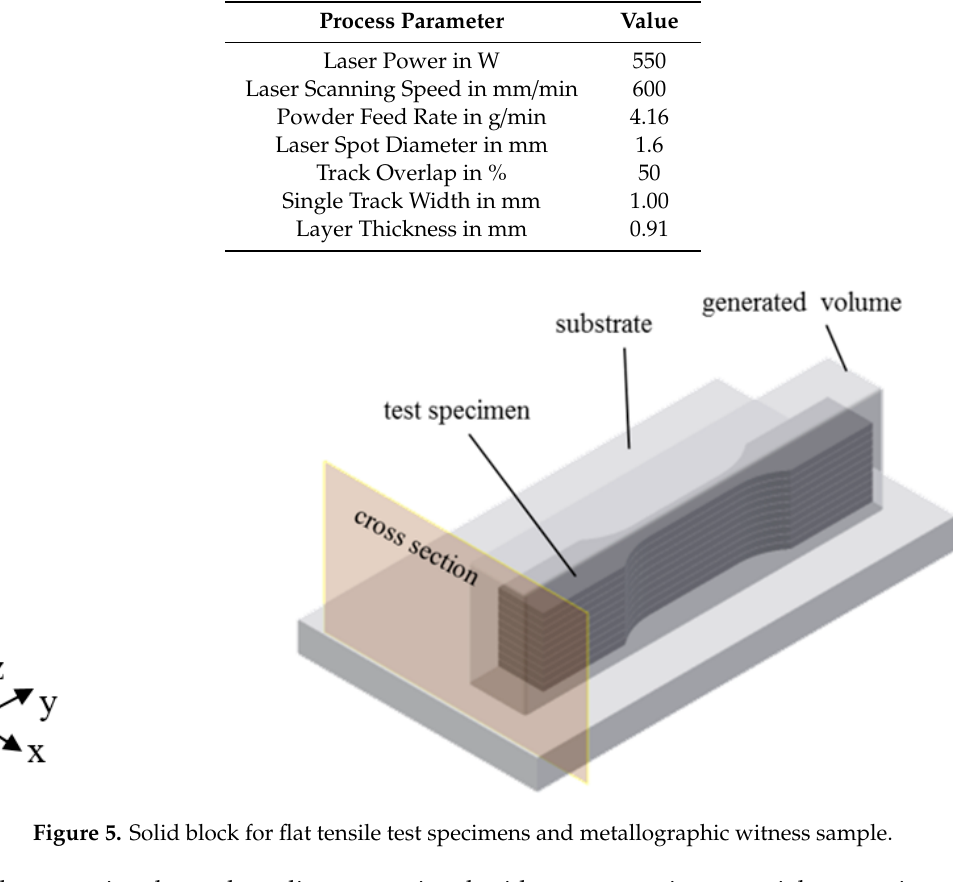
Table 2. Material sample parameter set.